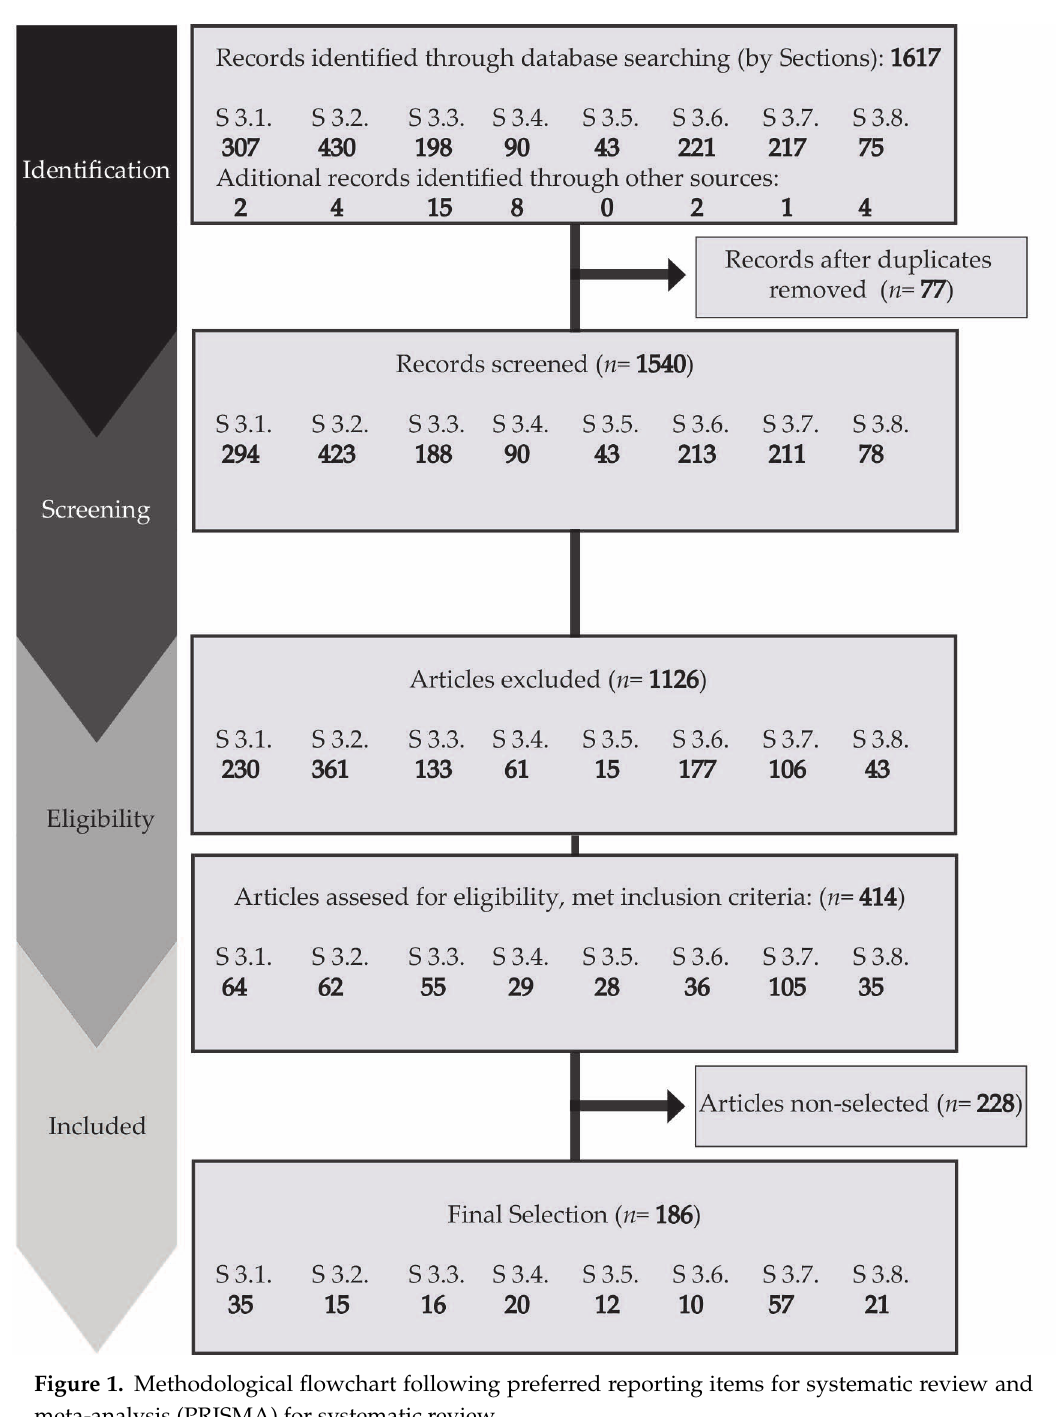
Figure 1. Methodological flowchart following preferred reporting items for systematic review and meta-analysis (PRISMA) for systematic